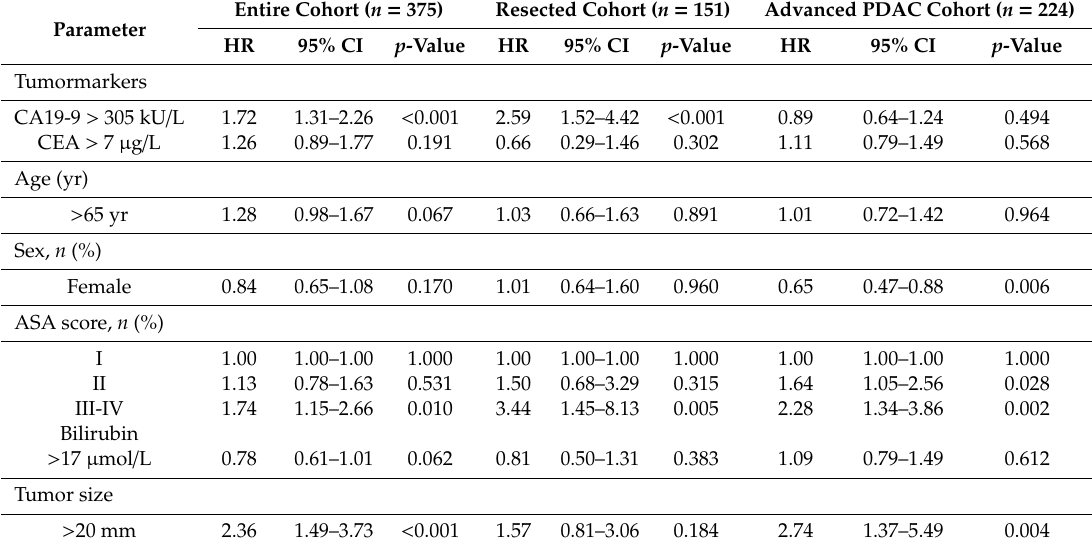
Table 2. Multivariable cox regression analysis for overall survival.